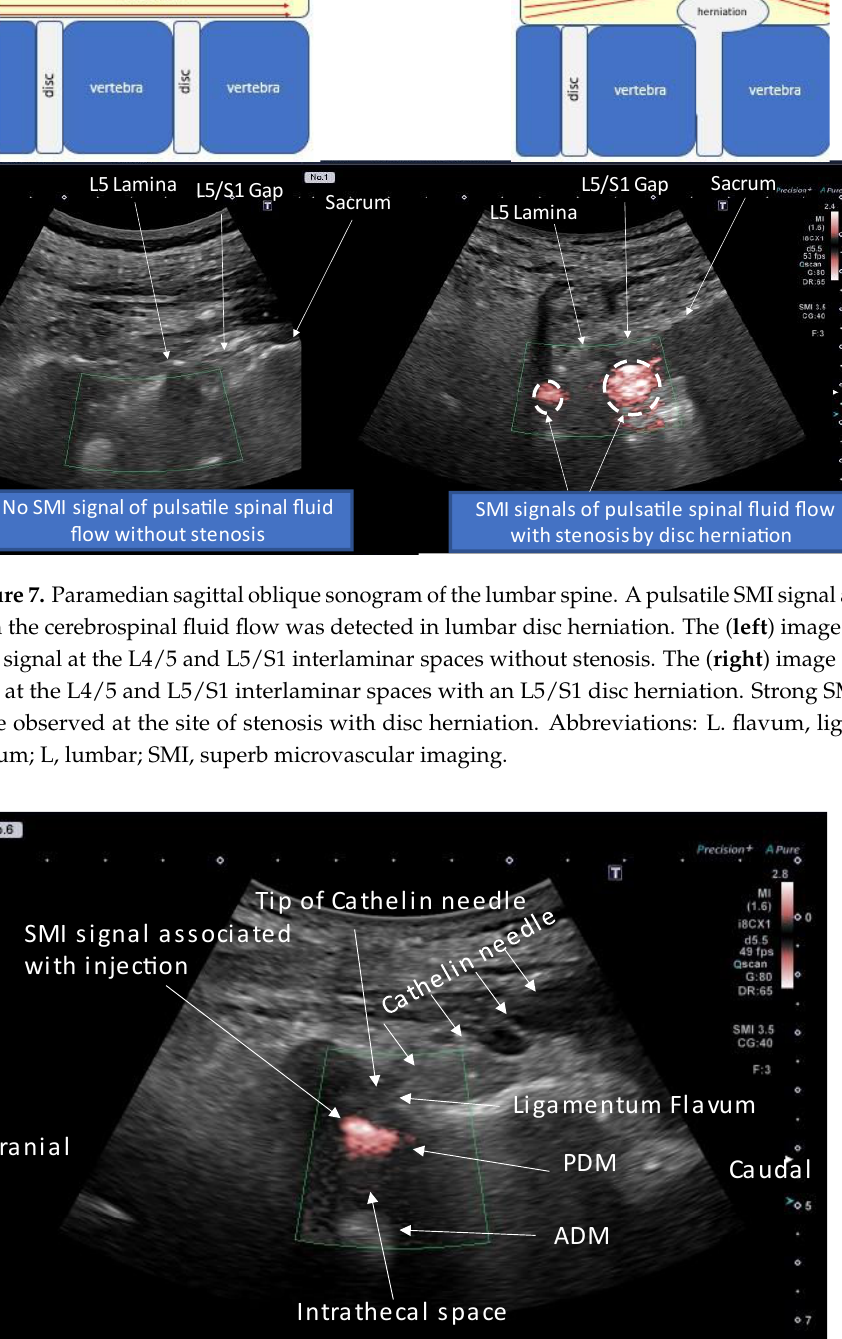
Figure 8. SMI steady-flow signal associated with injection. Paramedian sagittal oblique view (rotated by 20 ◦ ) of the lumbar spine during real-time US-guided epidural injection. Abbreviations: ADM, anterior dura matter; PDM, posterior dura matter; SMI, superb microvascular imaging.